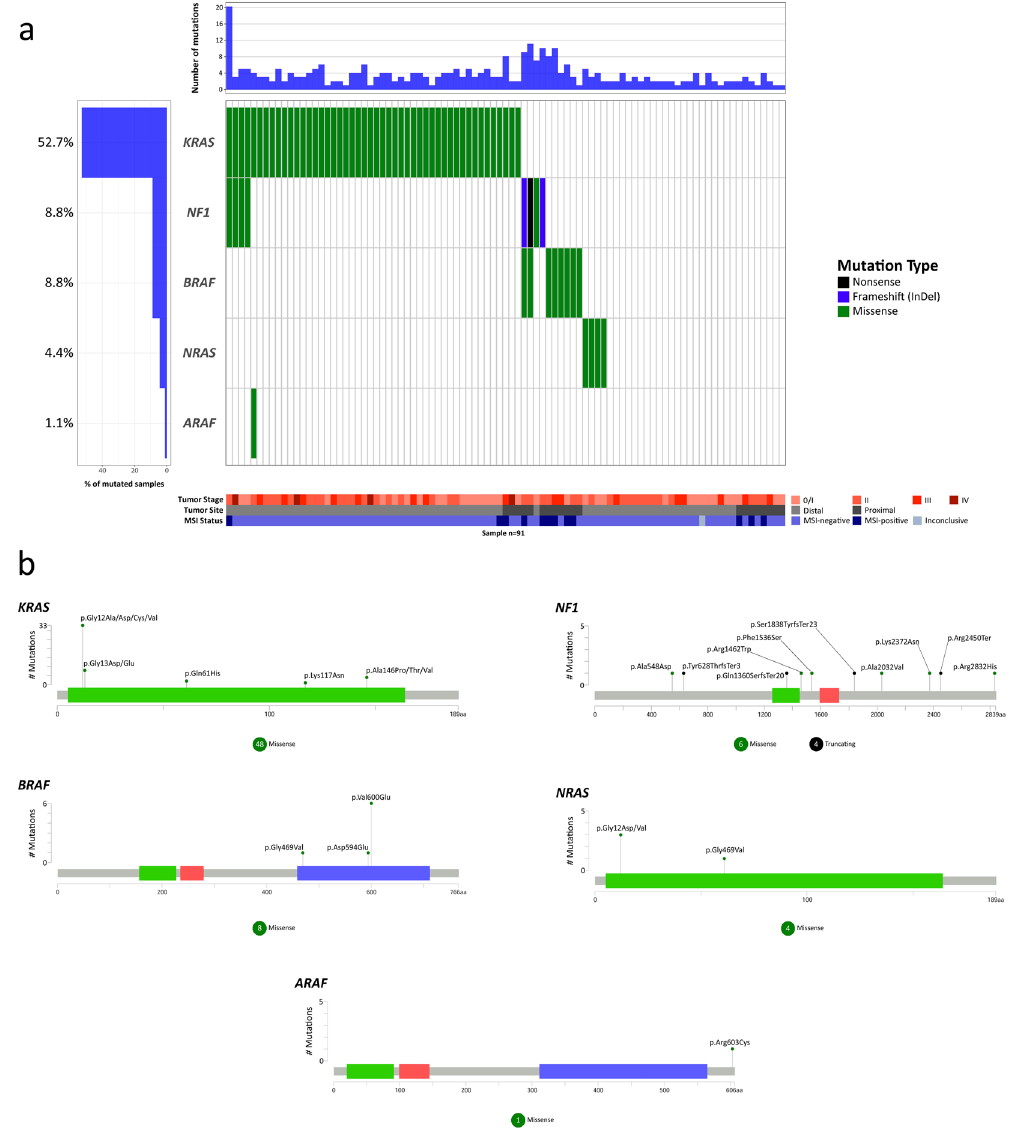
Figure 2. Waterfall (oncoplot) plot ( a ) and mutations mapper ( b ) of MAPK-ERK signaling pathway genes. Tumor stage: stage of the disease at diagnosis. MSI: microsatellite